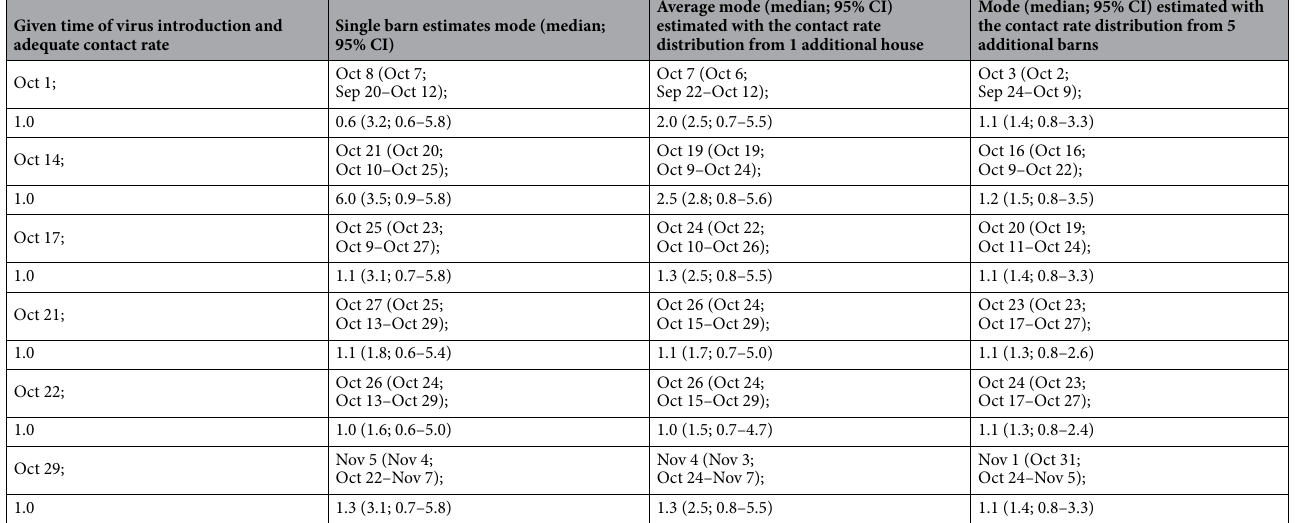
Table 3. Validation results given barns were infected 19, 6, and 3 days prior to and 1, 2, and 9 days after the date of the first test, assumed to have been performed on October 20. The time of virus introduction